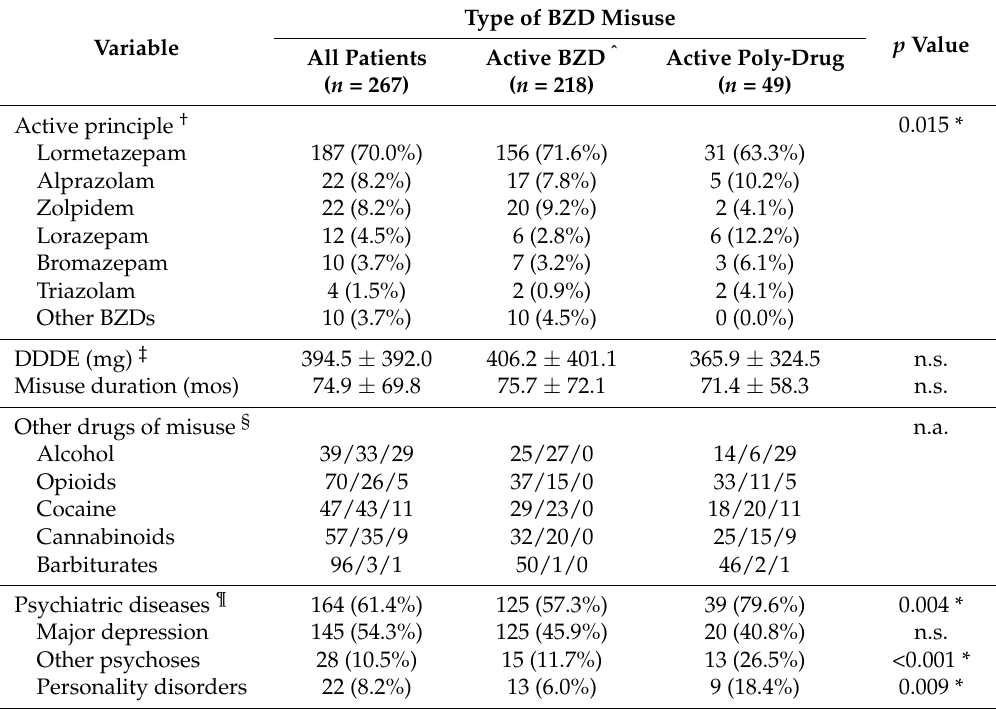
Table 2. Type of BZD misused by patients, daily dosage, misuse duration, other drugs of misuse and coexisting psychiatric